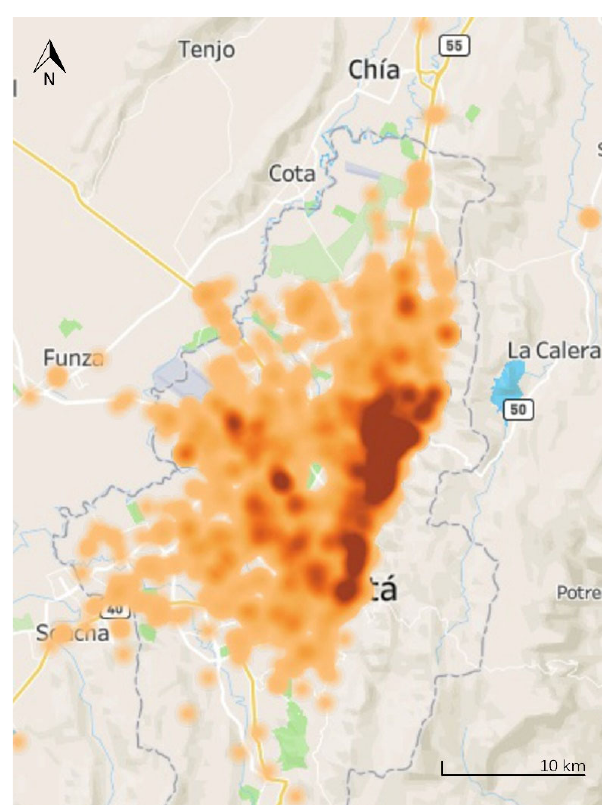
Fig. 2. Heat map of the amount of cargo delivered in